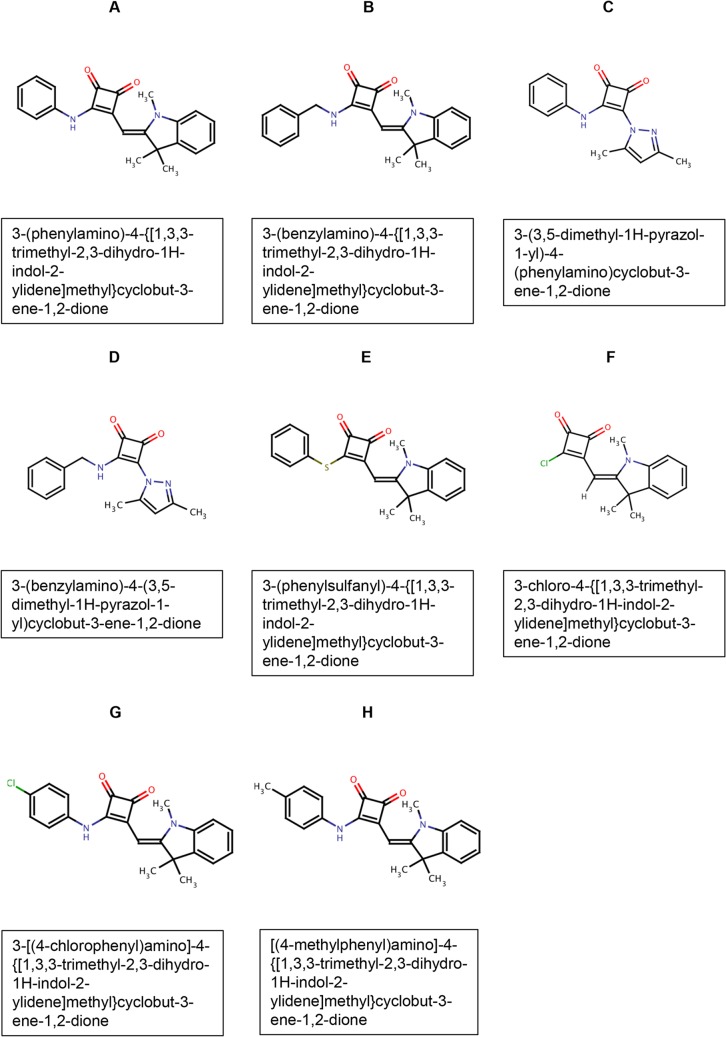
Compound structures.The compound name (A-H, see Table 2) is shown above each structure and its full IUPAC name in the box underneath.